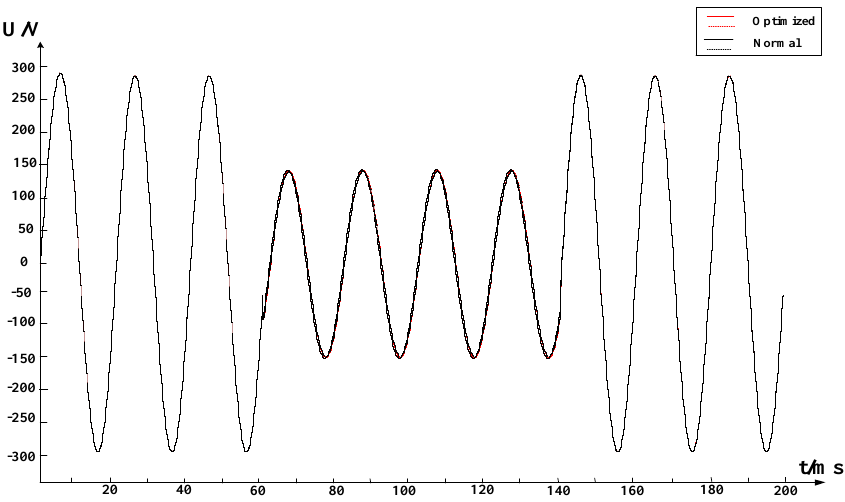
Energies 2019 , 12 , x FOR PEER REVIEW Figure 14. Comparison of adjacent load voltage waveforms for different strategies at 50% voltage sag. Figure 14. Comparison of adjacent load voltage waveforms for di